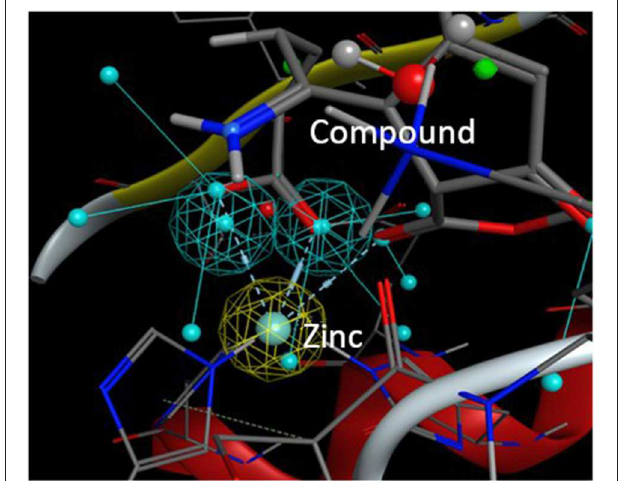
FIGURE 2 | Pharmacophore model BFT-3 active site. Docking and interaction of a compound (sticks) with the BFT-3 active site (lines) guided by